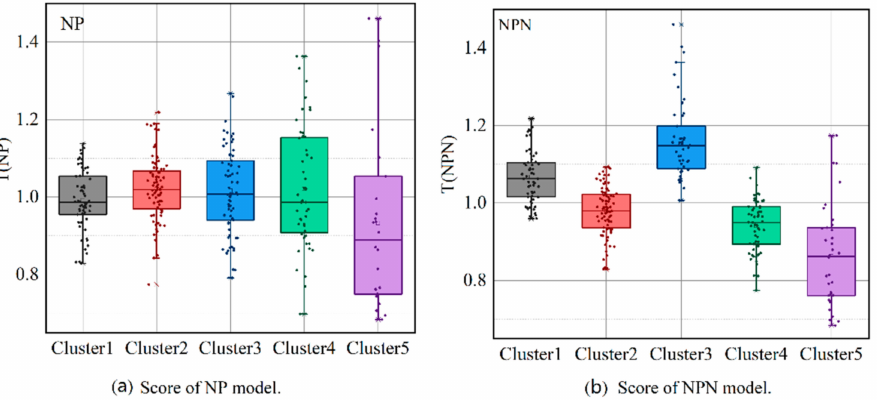
Figure 10. Score of the NP and NPN